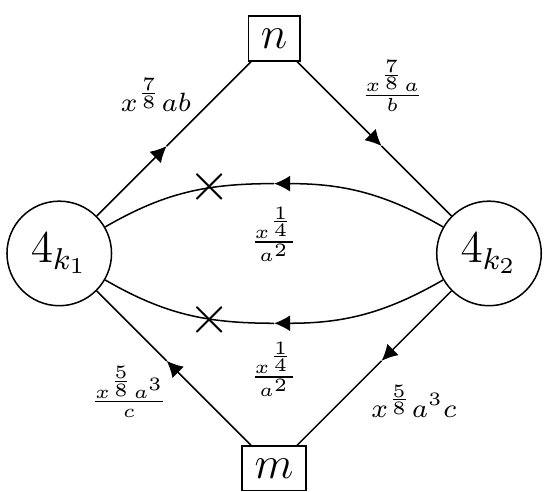
Figure 10 . Quivers for the models with N = 3 and split of the flavors ( n, m ) . We also summarize our conventions for the abelian symmetries and the R-symmetry. Notice that these are consistent with a cubic superpotential for the upper triangle involving the n flavors and one copy of the bifundamentals and a quintic superpotential for the lower triangle involving the m flavors and three copies of the